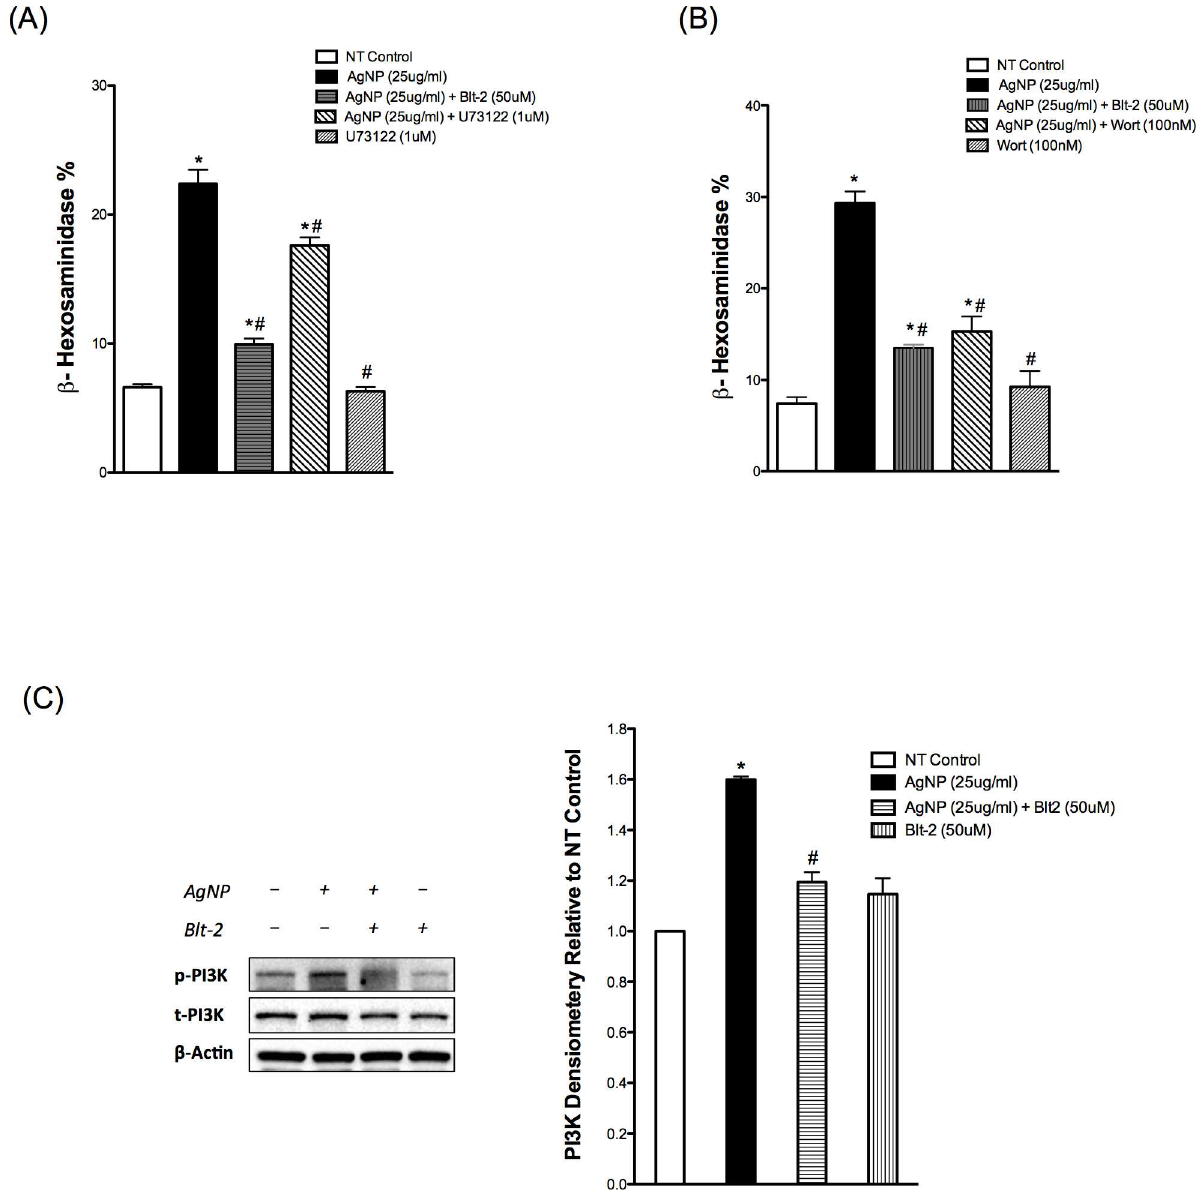
Fig 4. PLC and PI3K signaling in response to AgNPs Mast cell degranulation was assessedby measuring the release of β - hexosaminidaseinto supernatants. Cells were pre-treatedwith (A) the PLC γ inhibitorU73122(1 μ M) or (B) the PI3K inhibitor wortmannin (100 nM) 30 min prior to AgNP (25 μ g/ml) exposure for 1 h and releaseof β -hexosaminidasewas assessed. (C) Representative immunoblots for p-PI3K in samples pretreatedwith or without Blt-2 (50 μ M) and followedby AgNP exposurefor 1 h. Values are expressed as mean ± SEM of at least 3 independentexperiments. * Indicatessignificantdifference from controlledgroup (p (cid:20) 0.05). #Indicates significantdifference from AgNP-treated group (p (cid:20)